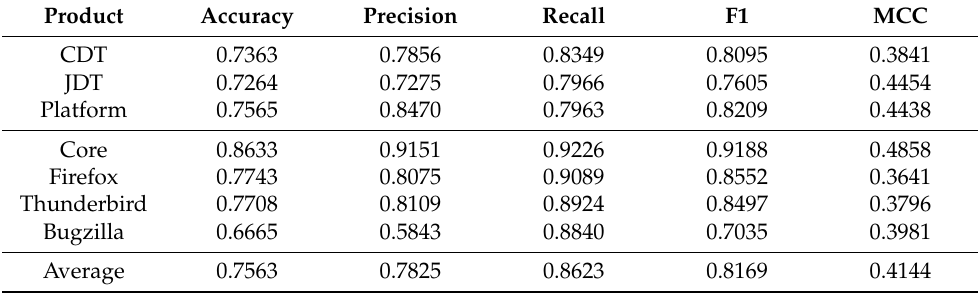
Table 6. Prediction performance of